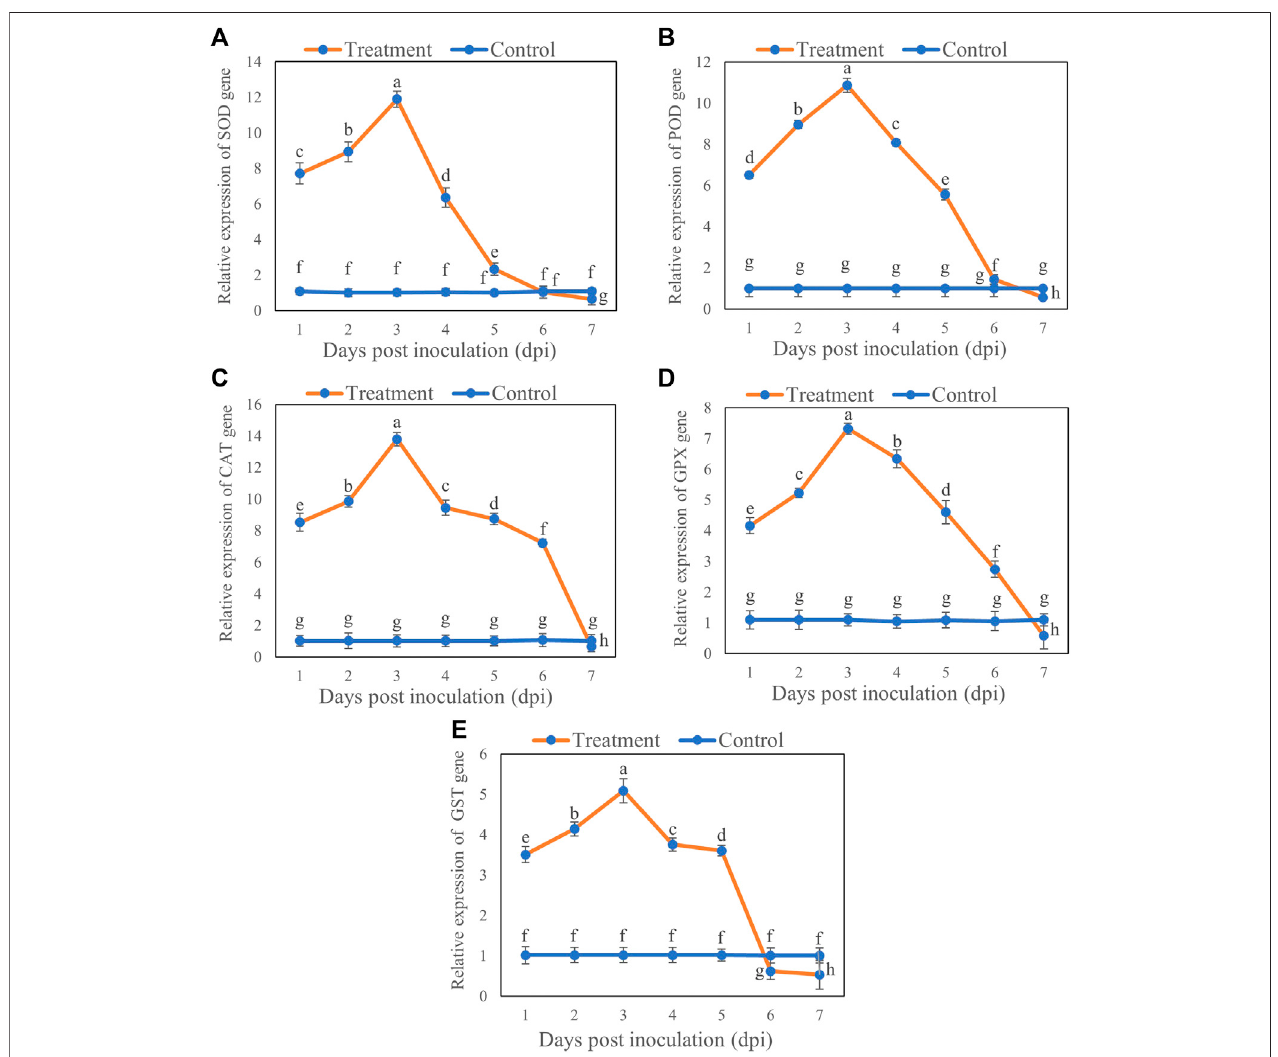
FIGURE 5 | Relative expression of (A) SOD, (B) POD, (C) CAT, (D) GPX and (E) GST genes in B. brassicae at different time points after inoculation with T. longibrachiatum T6. Different small letters represent the signi fi cant difference at the p < 0.05 level by Duncan ’ s new multiple range test. The line bars represent means ± standard